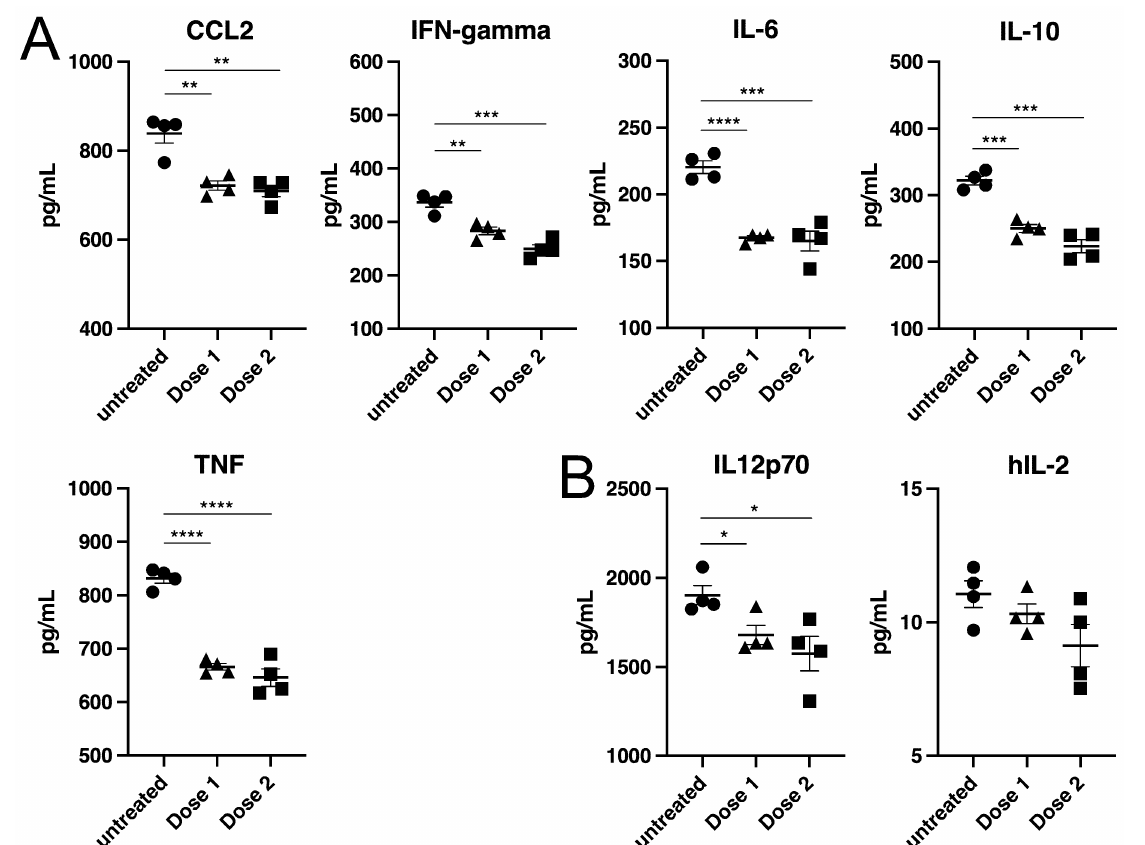
Figure 6. Measurement of cytokines after irradiation of medium. ( A ) A mixture of murine proinflammatory cytokines, produced from interaction of murine Tcon and Treg cells, was used to evaluate impact on cytokine detection ( B ) The amount of human IL-12p70 and IL-2 remaining in culture medium after irradiation. Samples were dosed at 1.9 (Dose 1) or 2.6 MRad (Dose 2). Amounts of the indicated cytokines were then measured using cytometric bead array assays. Replicates are indicated together with means and standard deviations. Circles are for untreated samples, triangles for 1.9 MRad and squares for 2.6 MRad dosed samples. * p < 0.05, ** p < 0.01, *** p < 0.001, **** p < 0.0001